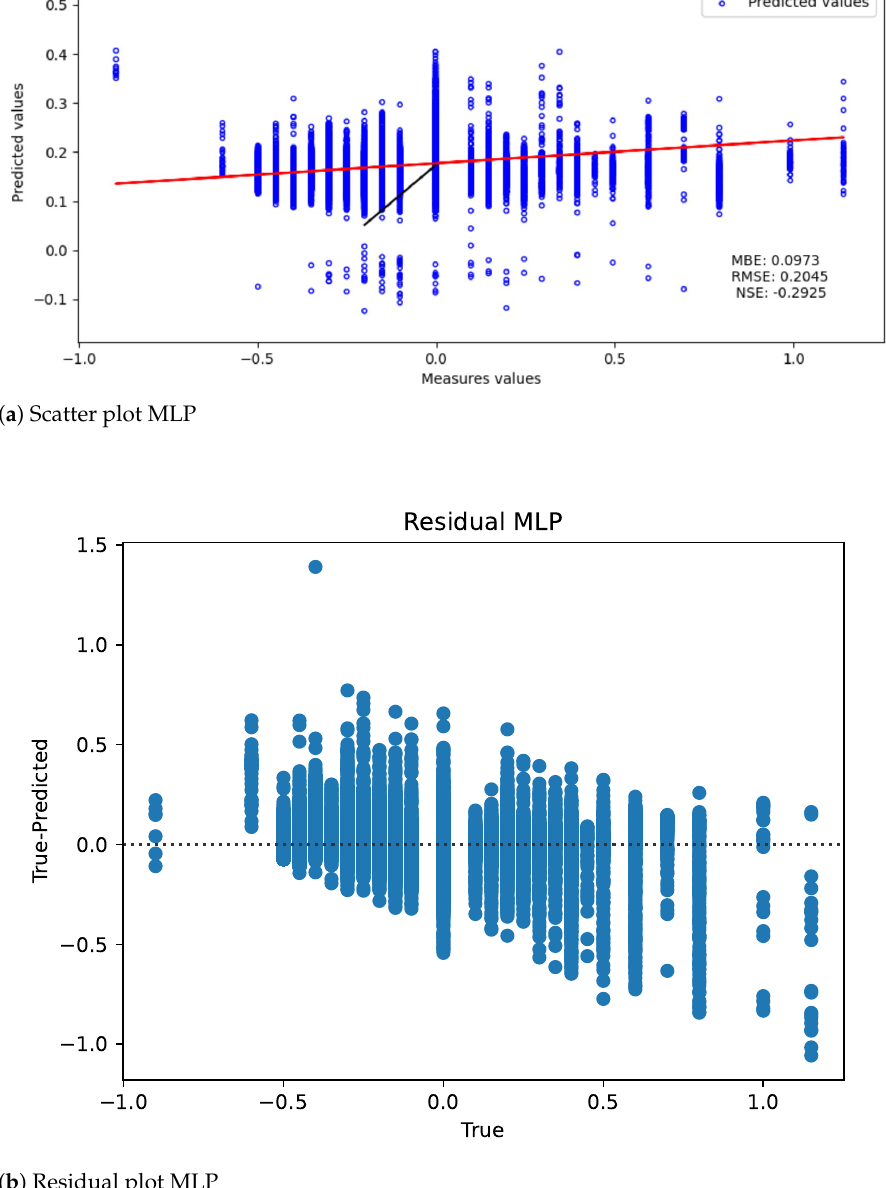
Figure 9. MLP results for ST deviation calculation in ECG time